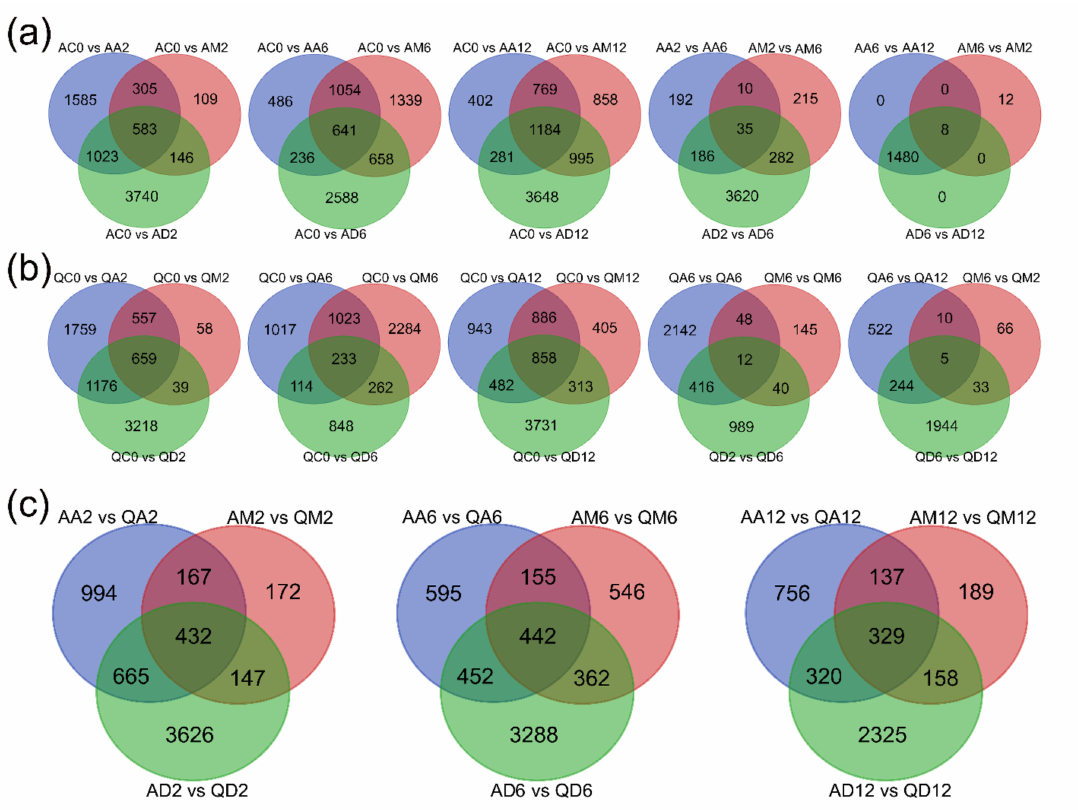
Figure 2. Venn diagram of DEGs distributed in every comparison. ( a ) Statistics of DEGs distributed among methylation inhibitor, simulated drought, and dual treatment in variety A. ( b ) Statistics of DEGs distributed among methylation inhibitor, simulated drought, and dual treatment in variety Q. ( c ) Statistics of DEGs distributed among three kinds of treatments in variety A and